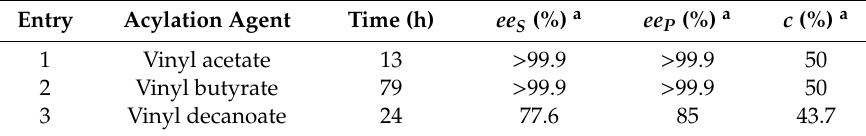
Table 2. Determination of the optimal acylation agent.